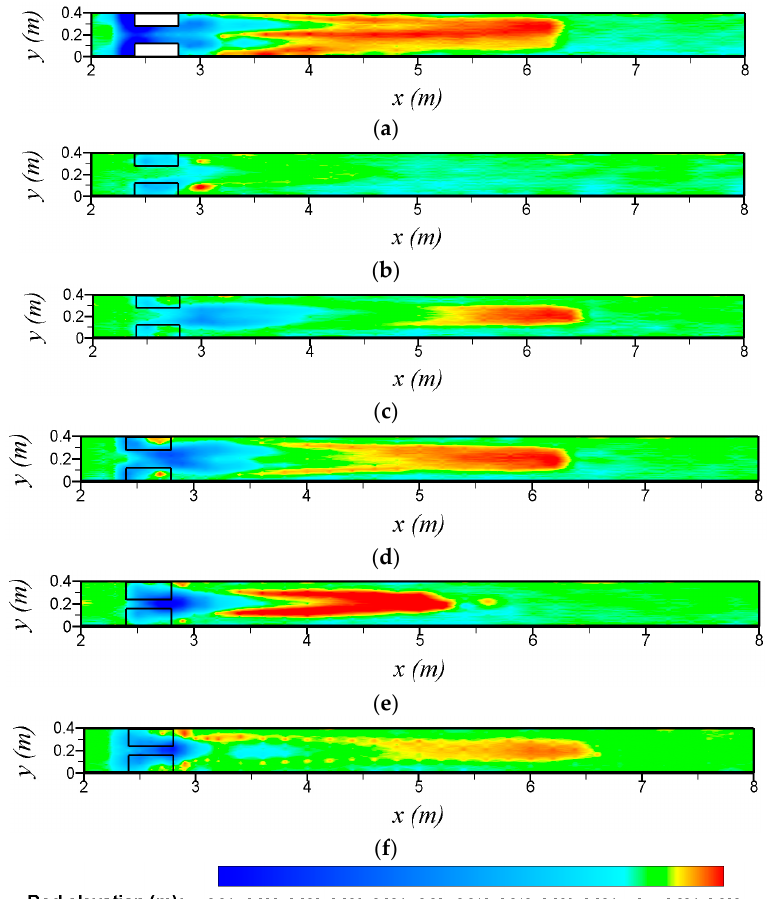
Figure 4. Changes in bed topography. The solid lines are the porous obstructions and the flow is left to right. ( a ) Solid obstructions ( W v = 0.08 m, h / h p = 1.0); ( b ) Porous obstructions (2 aW v / W = 2.5, h / h p =